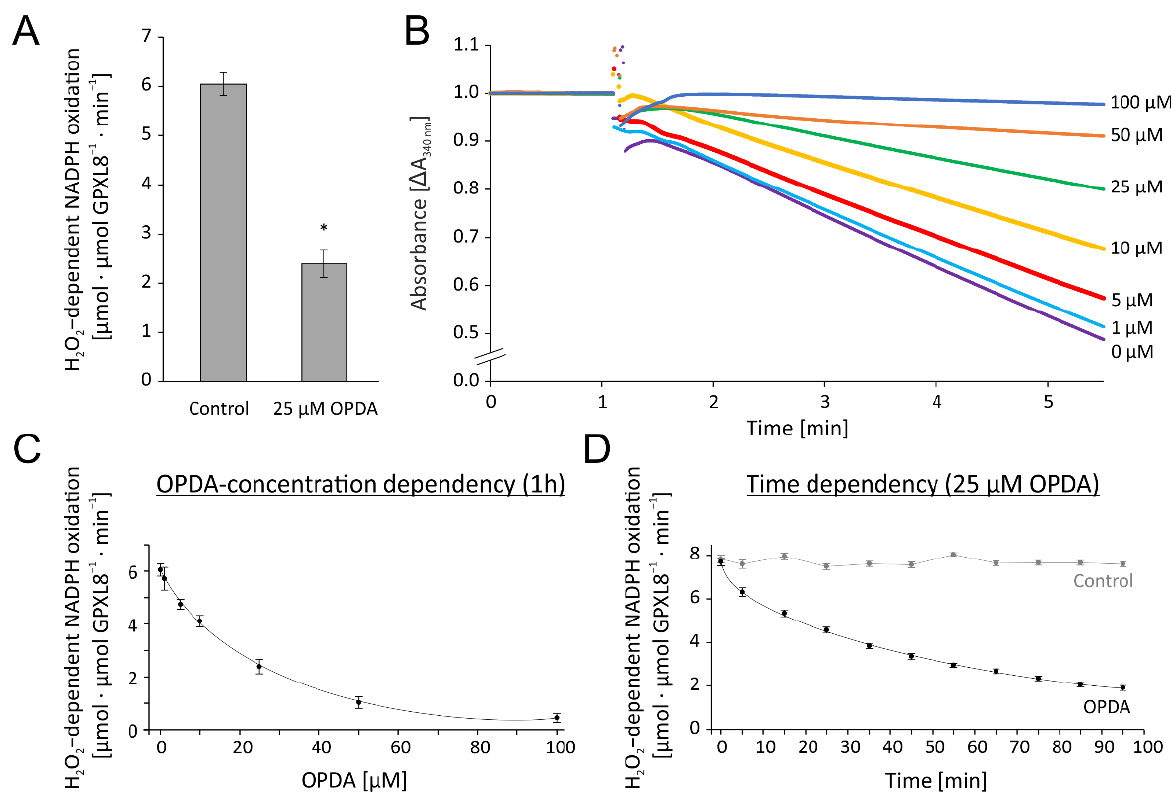
Figure 6. OPDA effect on glutathione peroxidase-like (GPXL)-dependent H 2 O 2 detoxification using the reconstituted assay. ( A ) Effect of 25 µM OPDA on TRXh3-dependent GPXL8 activity. The reaction mix contained 200 µM NADPH, 1 µM NTRA, 0.25 µM TRX-h3, 3 µM GPXL8 and was